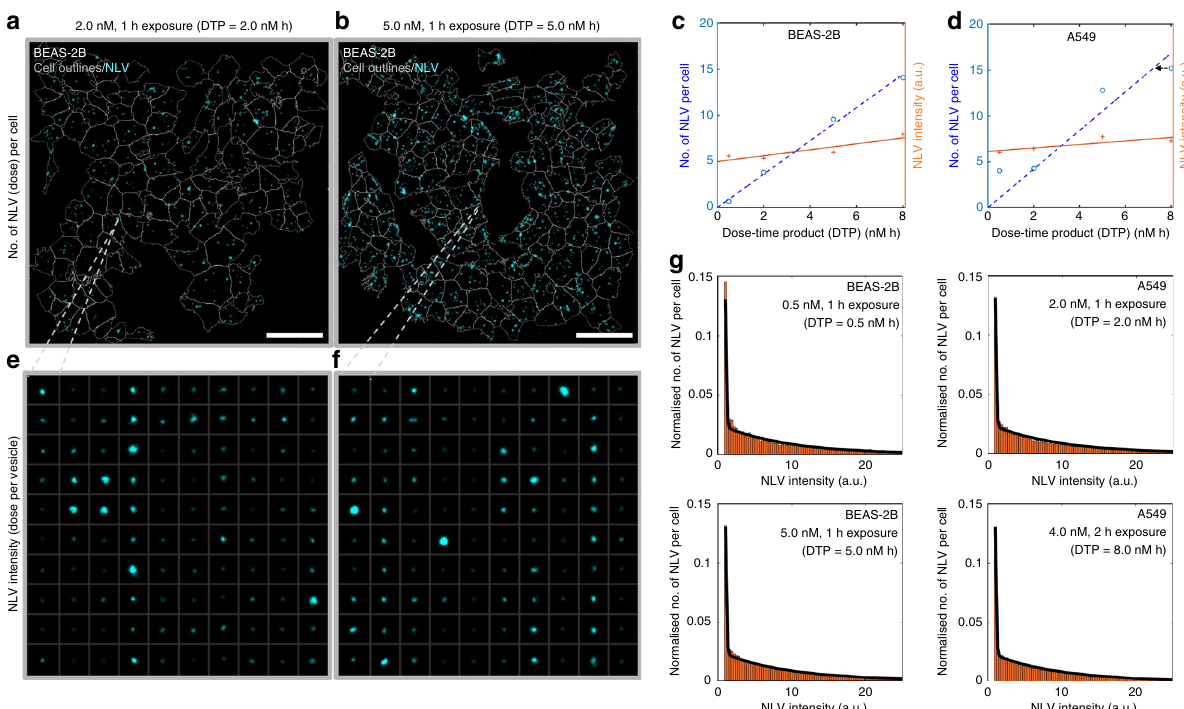
Fig. 2 NLV analysis across different cell lines and exposure conditions. a , b Typical fi elds-of-view for the BEAS-2B cells demonstrating the expected increase in the number of NLVs per cell that occurs when the nanoparticle exposure dose – time product (DTP) was increased from 2 nM h ( a ) to 5 nM h ( b ). c , d Taken across all image data, the mean number of NLVs per cell (blue circles) and the mean intensity of each NLV (orange crosses) are plotted versus the dose – time product for the BEAS-2B and A549 cells. The blue and orange lines represent least squares fi rst-order polynomial fi ts to the mean number of NLVs per cell or NLV intensity versus the dose – time product (respectively). The plots show that whilst the mean number of NLVs per cell (blue dashed line) increases with increasing exposure, the NLV intensity (i.e., proportional to the number of nanoparticles per vesicle) (orange line) remains remarkably similar. e , f This stability in the nanoparticle dose per endosome is visually apparent when 100 NLVs are randomly chosen from the two exposures shown in a / b : the montaged panels of NLV look near identical despite a 2.5-fold increase in the dose – time product. g Four typical NLV intensity histograms chosen from both cell lines and across the full 16-fold range of the dose – time product. The black line is the same, simultaneous fi t to all of the histograms, demonstrating the insensitivity of the nanoparticle dose per vesicle to the initial administered dose or exposure duration. (Scale bars = 100 μ m.) The underlying data are provided in the BioStudies database under the accession code